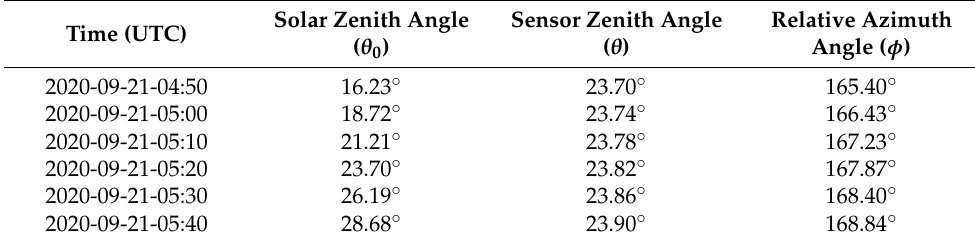
Table 2. Three angles of the leading wave in consecutive